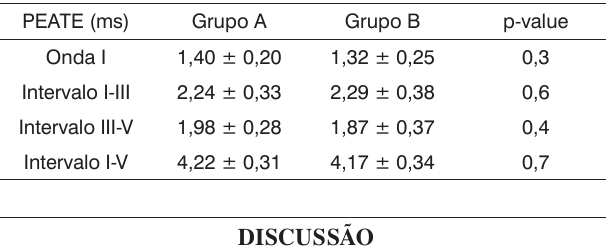
Tabela 4. Latências dos potenciais evocados auditivos